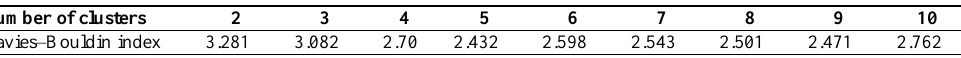
Table 1. Values for Davies-Bouldin index based on number of